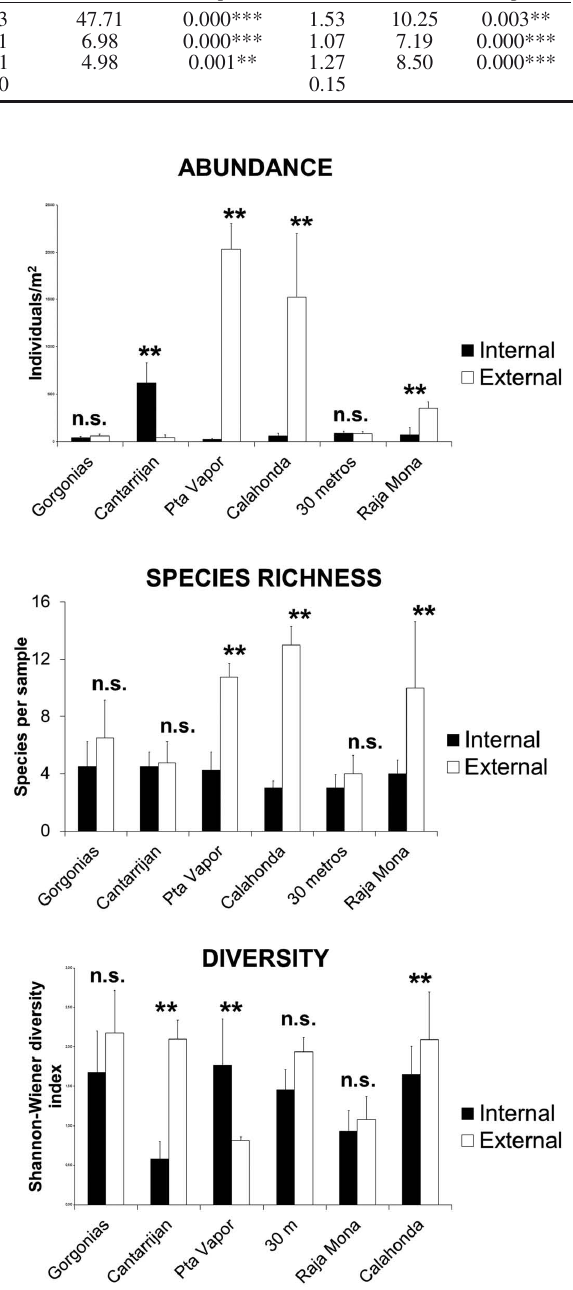
Fig. 2. – Mean values ± SD of abundance of individuals, number of species and Shannon-Wiener diversity index for each sampling station. Significance of differences between positions is also repre- sented. **, p<0.01; n.s., non